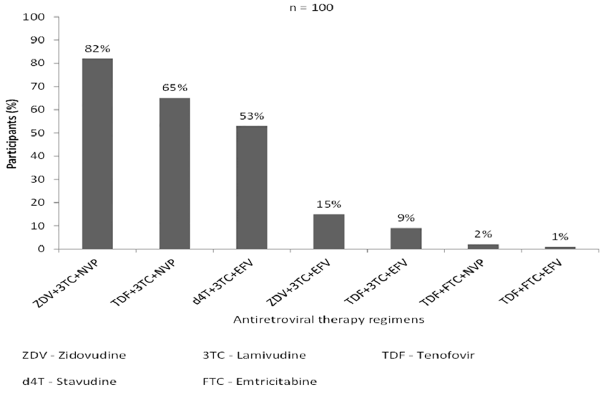
Fig 1. Antiretroviral regimens ever received by the